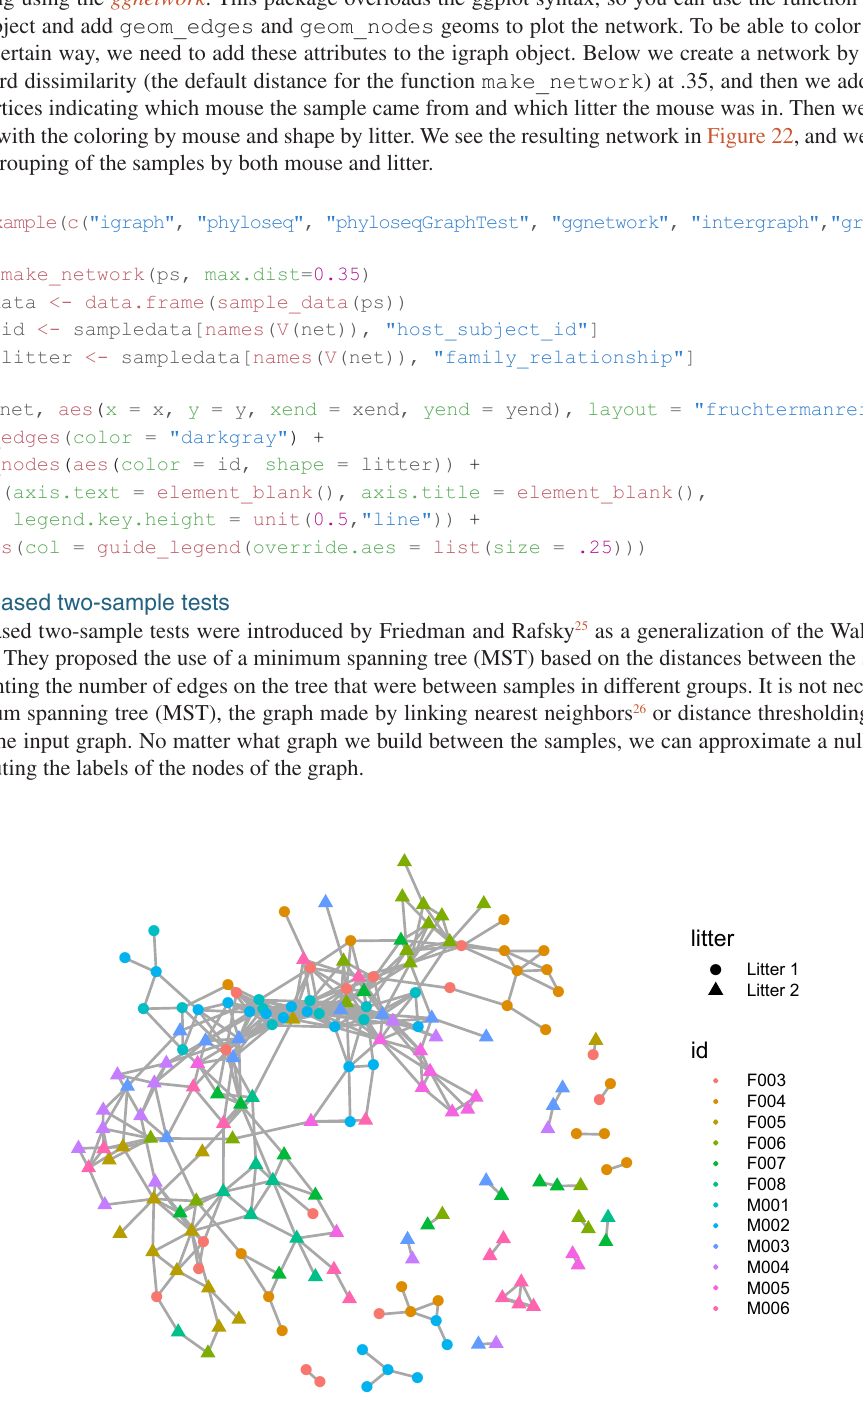
Figure 22. A network created by thresholding the Jaccard dissimilarity matrix. The colors represent which mouse the sample came from and the shape represents which litter the mouse was